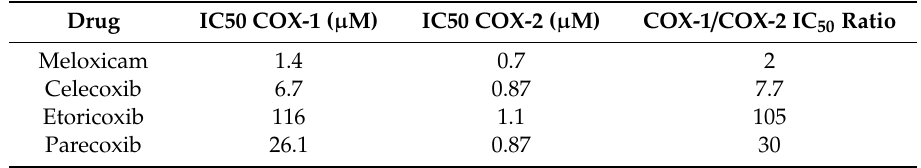
Table 4. The schematic overview of the half maximal inhibitory concentration (IC 50 ) values and